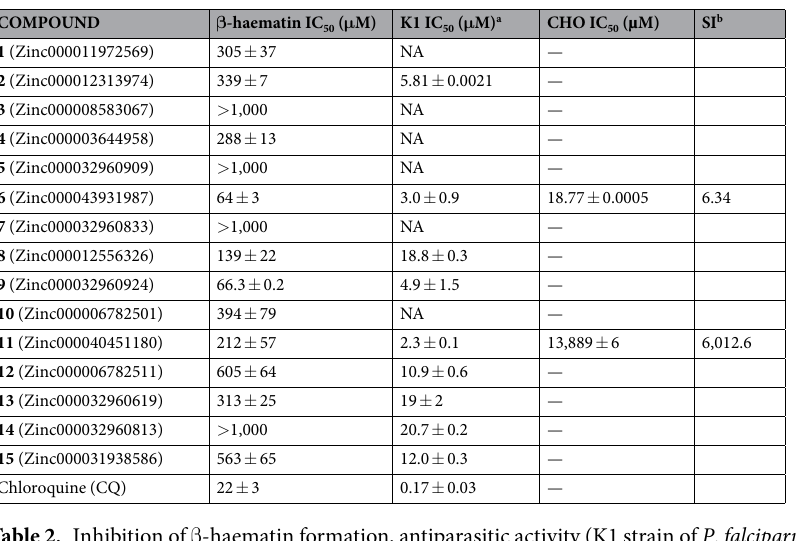
— Table 2. Inhibition of β -haematin formation, antiparasitic activity (K1 strain of P . falciparum ), cytotoxicity in a Chinese hamster ovarian (CHO) mammalian cell-line, and selectivity index (SI) of the purchased compounds. a NA = not active at tested concentration of 10 µ g/mL. b SI = Selectivity index = CHO IC 50 /K1 IC 50 .